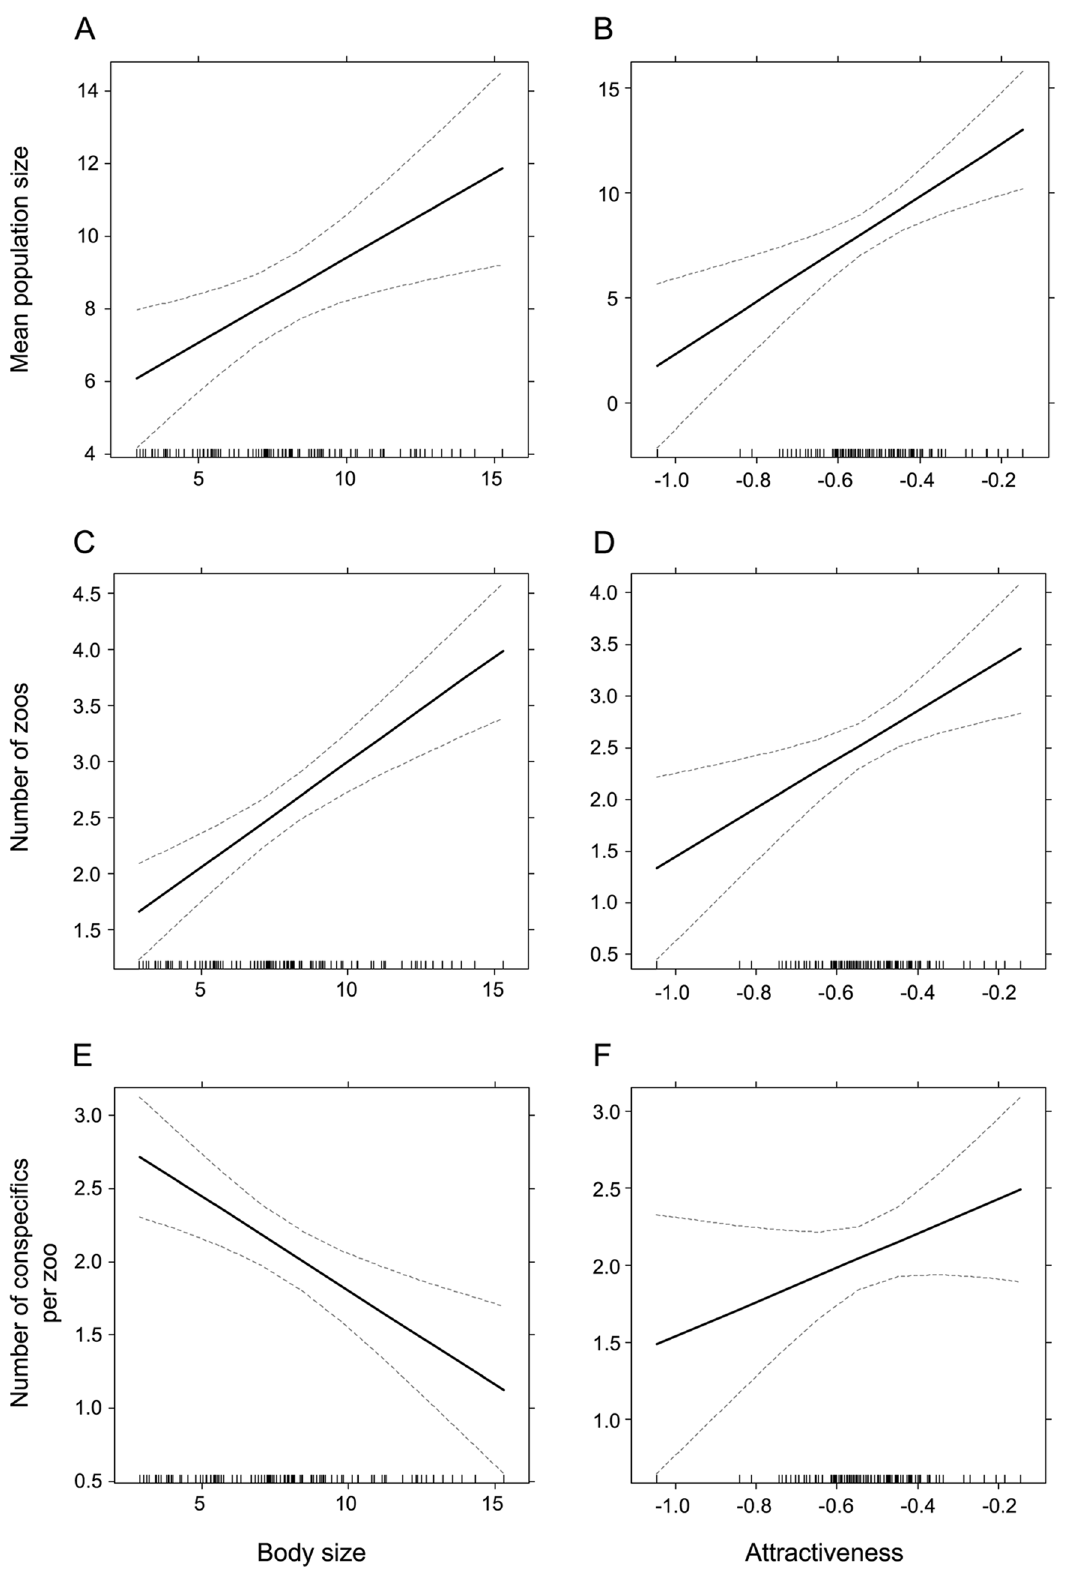
Figure 4. The effects of body size and attractiveness. The effects of body size and attractiveness on the mean population size (a,b), number of zoos (c,d) and number of conspecifics per zoo (e,f). The mean population size: The world zoo population size (square-root transformed) per species present in WZC. The number of zoos: The natural log-transformed mean number of zoos keeping the species. The number of conspecifics per zoo: